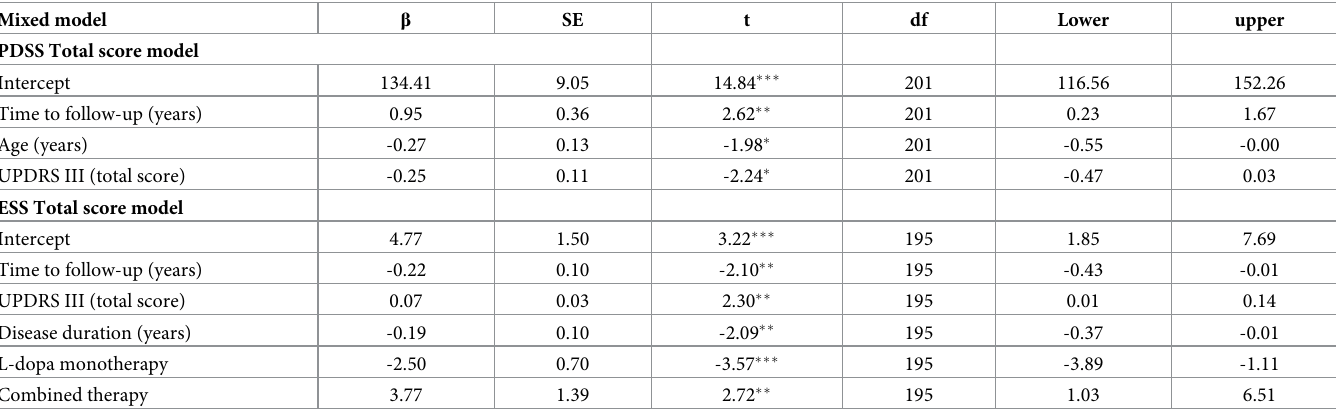
Table 2. Regression linear mixed model for PDSS and ESS Total